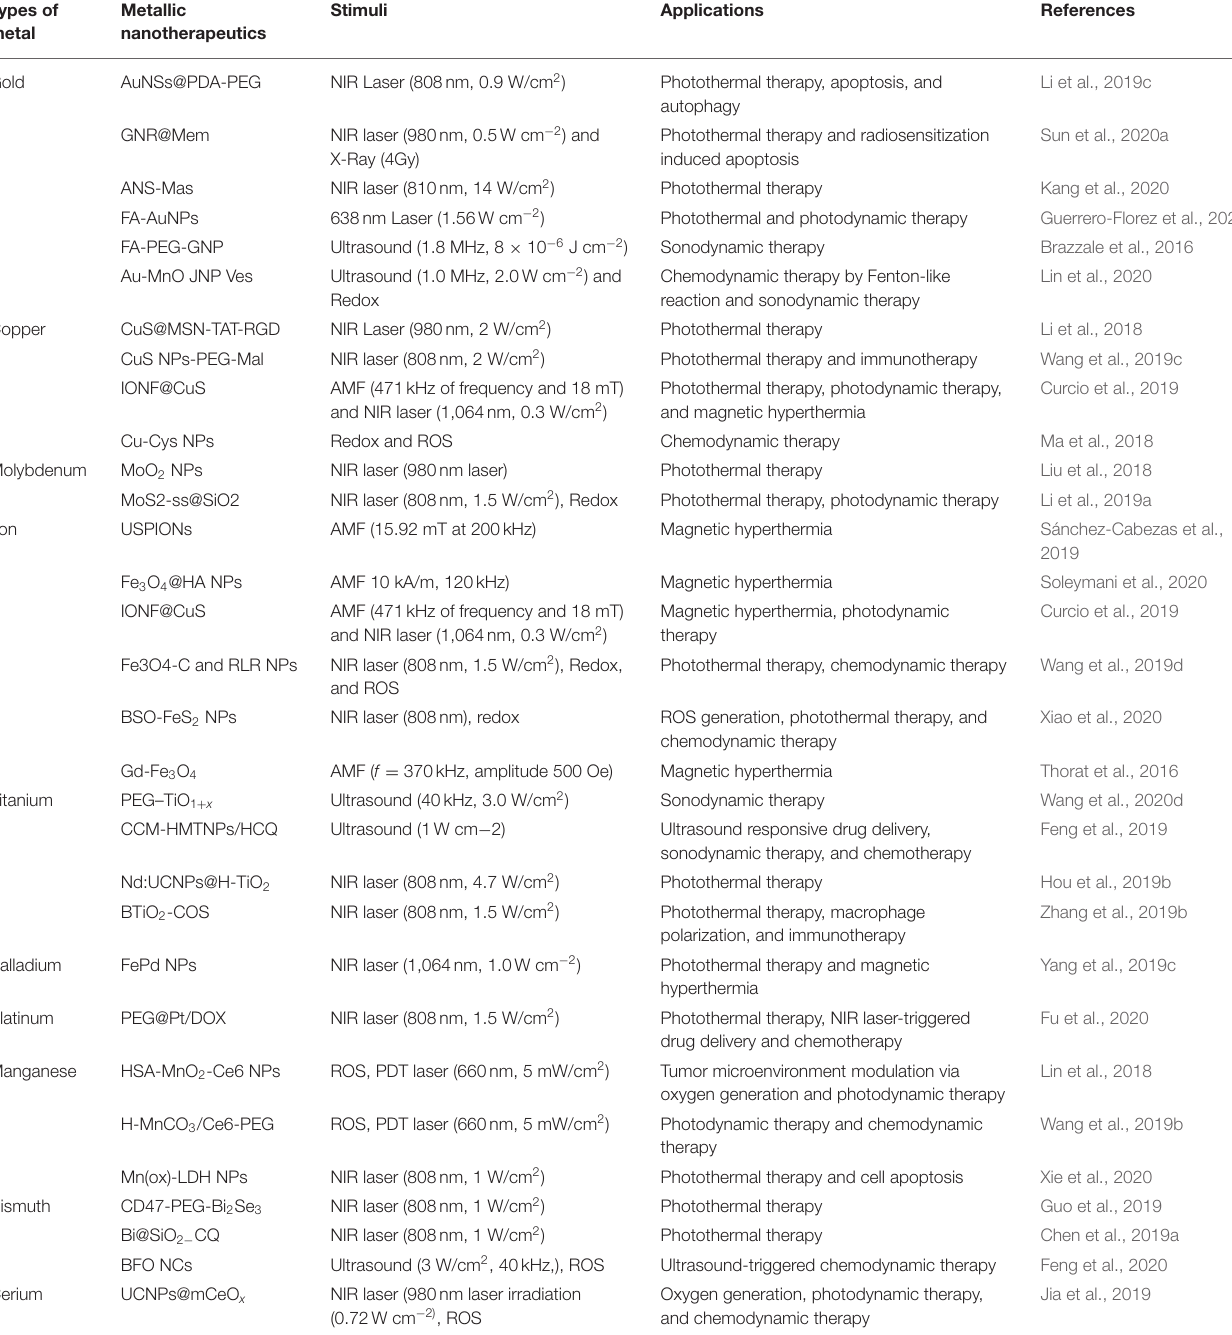
TABLE 2 | Stimuli-triggered metallic nanotherapeutics for multiple anticancer